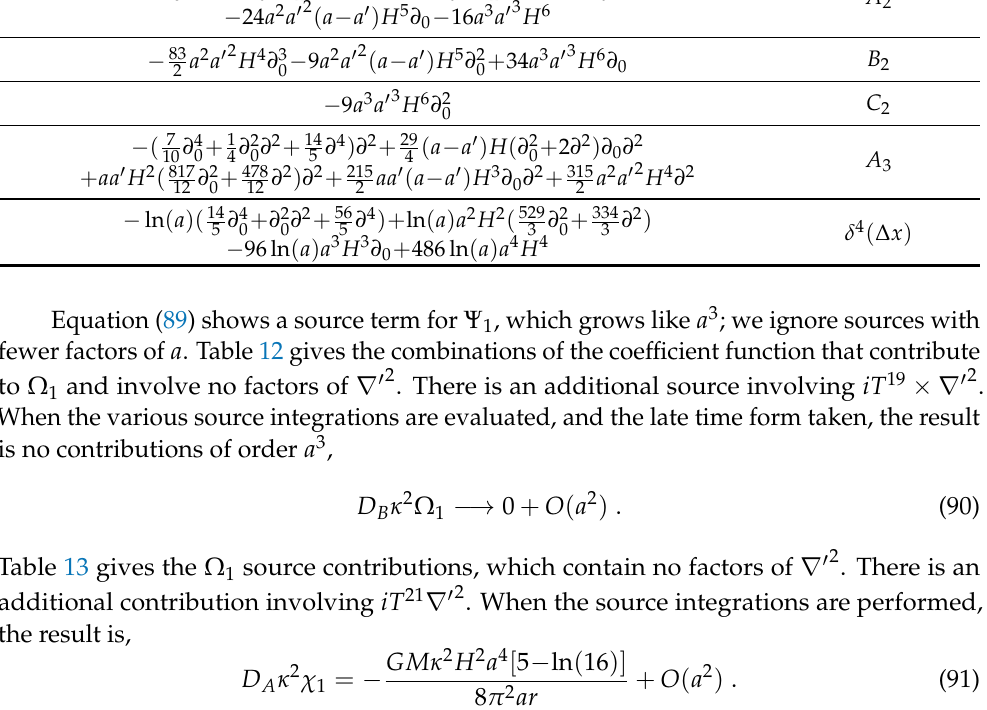
Table 12. Contributions for 3 iT 6 + iT 10 + iT 15 . Each tabulated term must be multiplied by κ 2 Operator